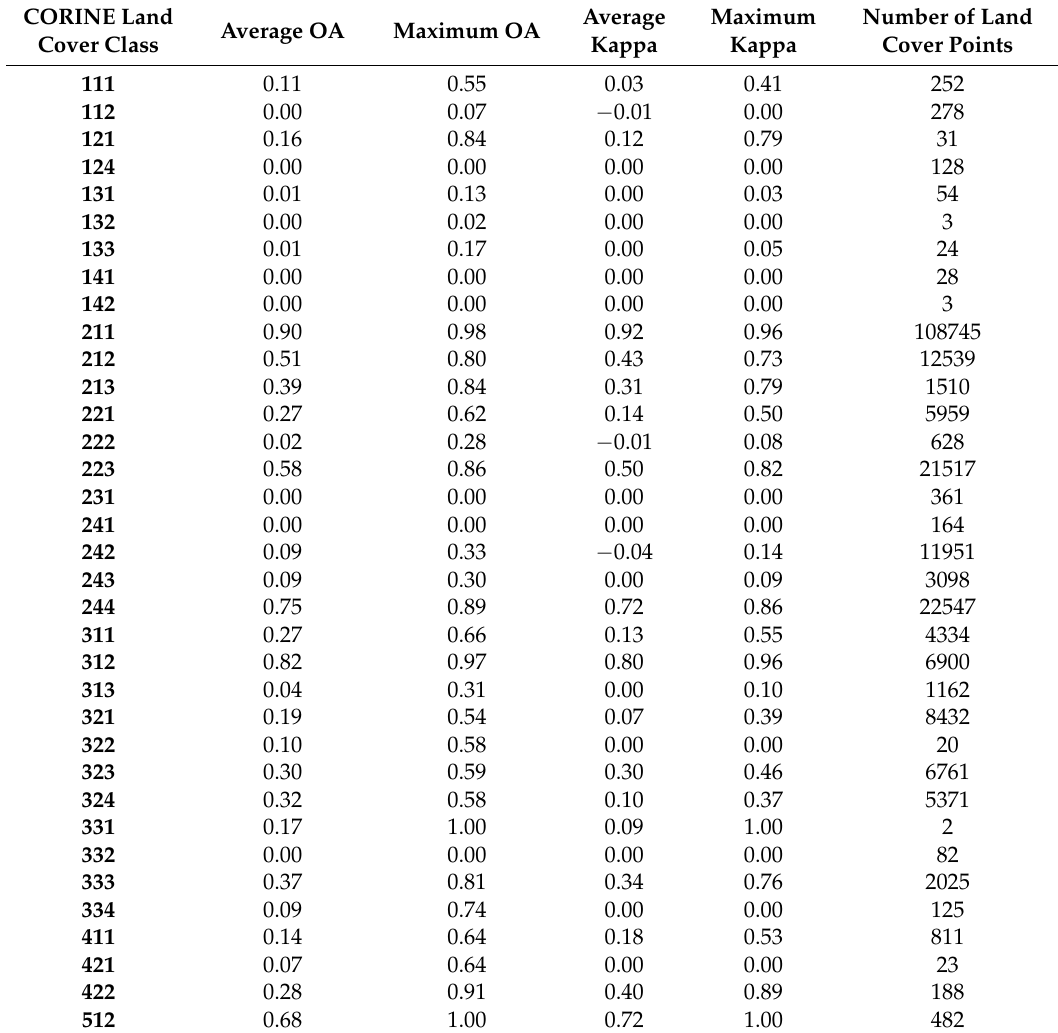
Table 5. Mean and maximum of all experiments for OA and kappa for Level 7 classifications.